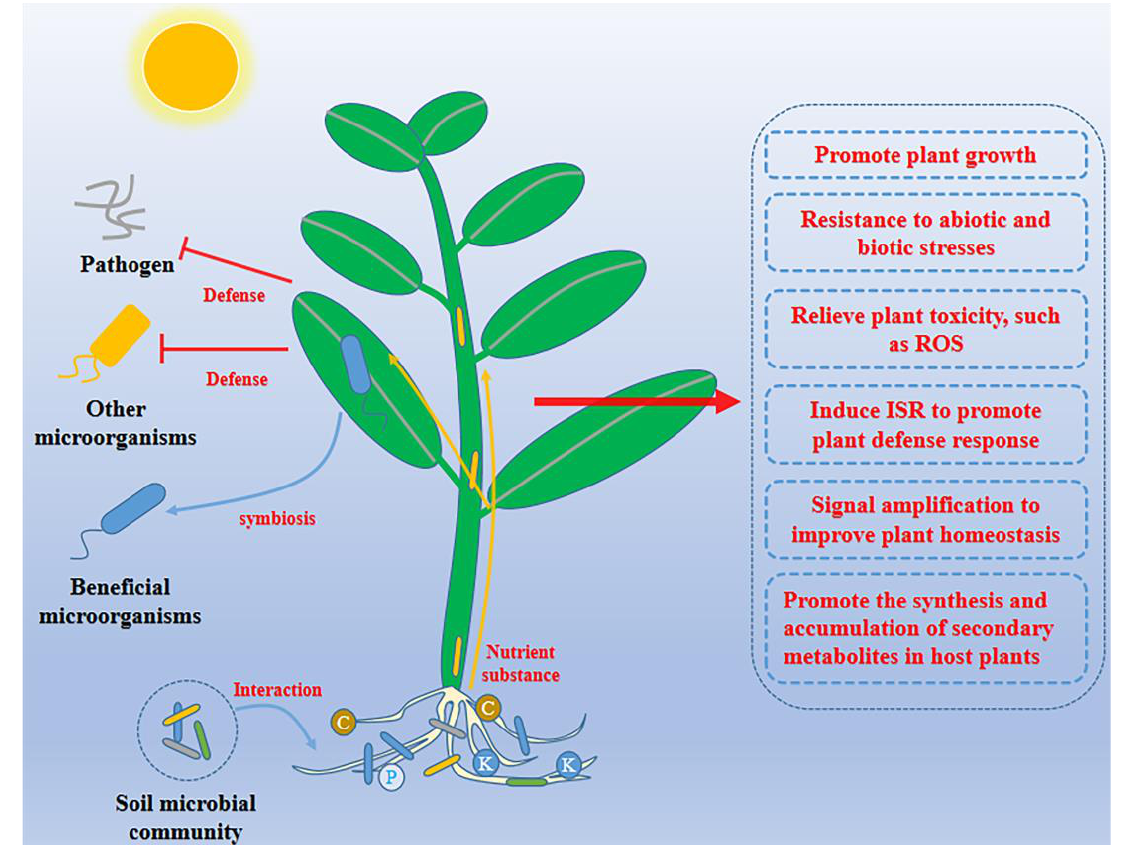
Figure 3. Plants recruit beneficial microorganisms to colonize and maintain the stability of the microecological system. As the plant grows, soil microorganisms are enriched, forming soil microbial communities at the roots. On the one hand, the interaction of microorganisms is used to improve the living environment, and on the other hand, inorganic elements in the soil (C, P, K, et al.) are enriched to provide nutrients needed for growth and development. In this process, plants release special substances that attract certain microorganisms from the environment and direct the colonization of beneficial microbes, triggering a range of physiological and biochemical reactions.